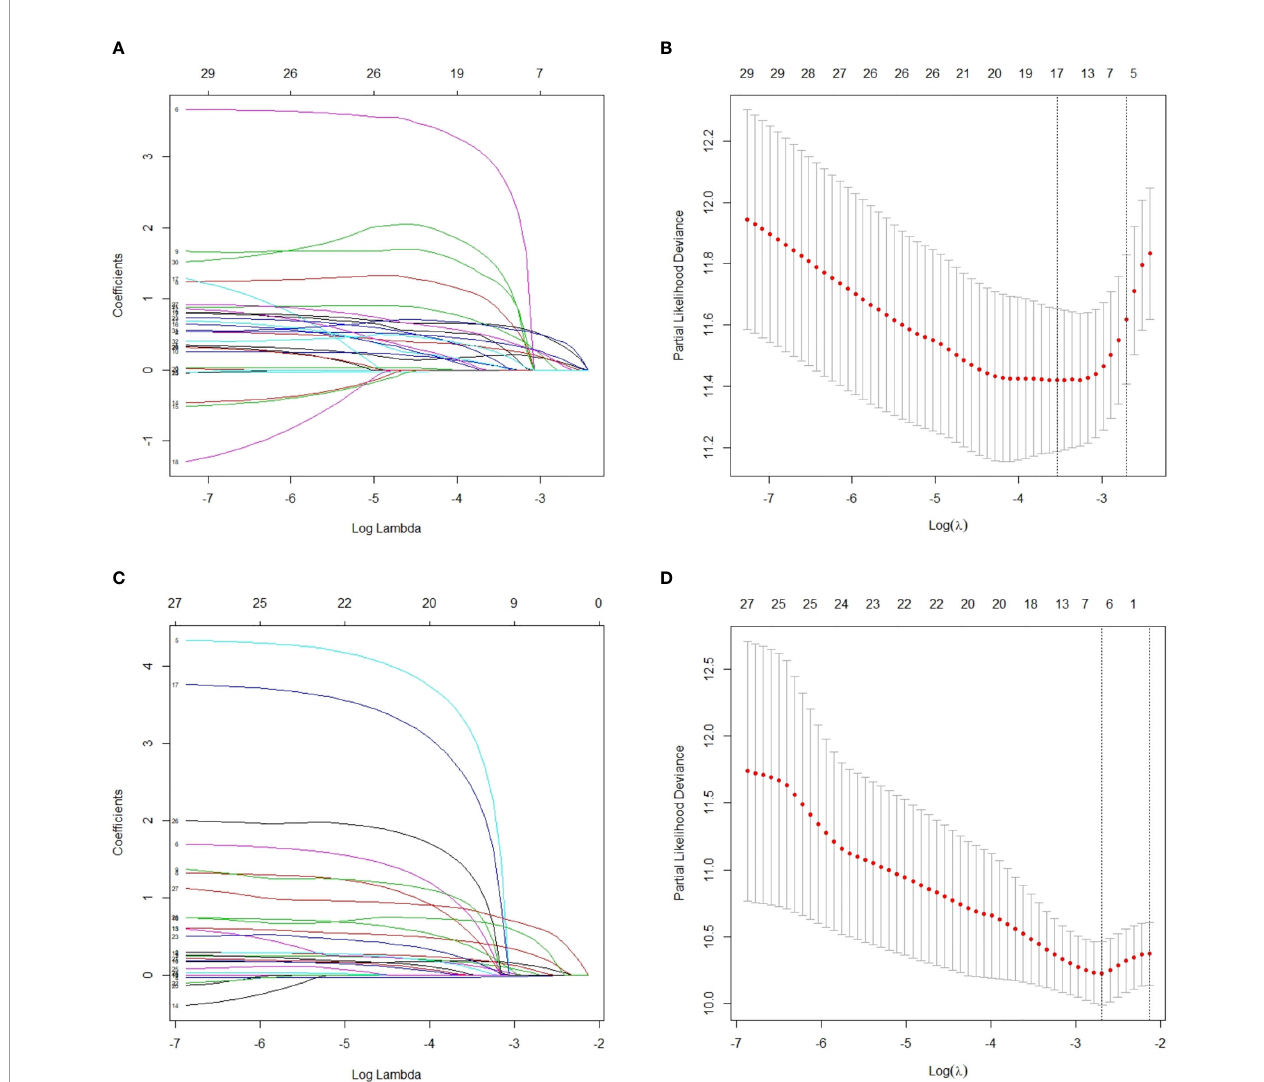
FIGURE 2 | After initial screening by univariate analysis, selection of variables for OS and PFS were performed using the LASSO method with a logistic regression model. (A) Model coef fi cient trendlines of the 32 variables for OS. The pro fi le graph was plotted by coef fi cients against the L1 norm (inverse proportional to log l = − 2.705). (B) Tuning parameter l in the LASSO model. The parameter l = 0.067 was selected under the minimum criteria. The vertical line was drawn at the value selected by 10-fold cross-validation, including optimized six non-zero coef fi cients. (C) Model coef fi cient trendlines of the 28 variables for PFS. The pro fi le graph was plotted by coef fi cients against the L1 norm (inverse proportional to log l = − 2.688). (D) Tuning parameter l in the LASSO model. The parameter l = 0.068 was selected under the minimum criteria. The vertical line is drawn at the value selected by 10-fold cross-validation, including optimized seven non-zero coef fi cients. OS, overall survival; PFS, progression-free survival; LASSO, least absolute shrinkage and selection